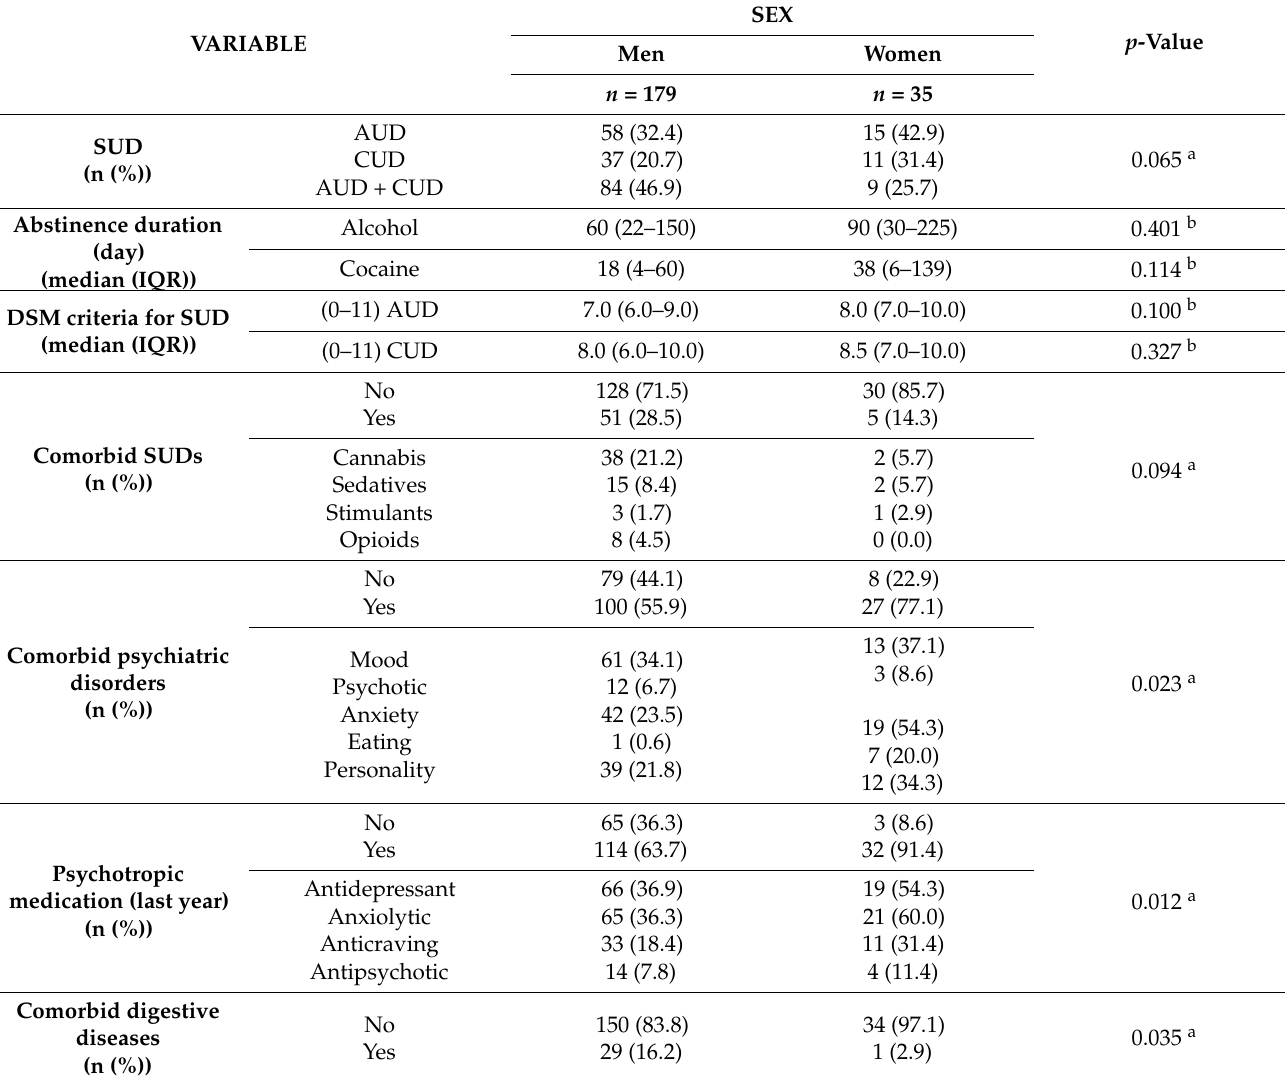
Table 5. Clinical and psychiatric variables of the SUD group based on